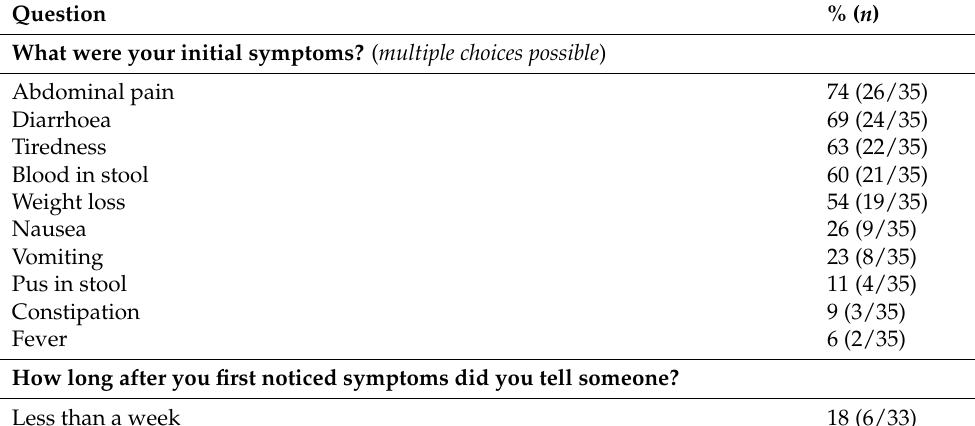
Table 2. Patient questionnaire: IBD symptoms and reporting prior to diagnosis ( n =